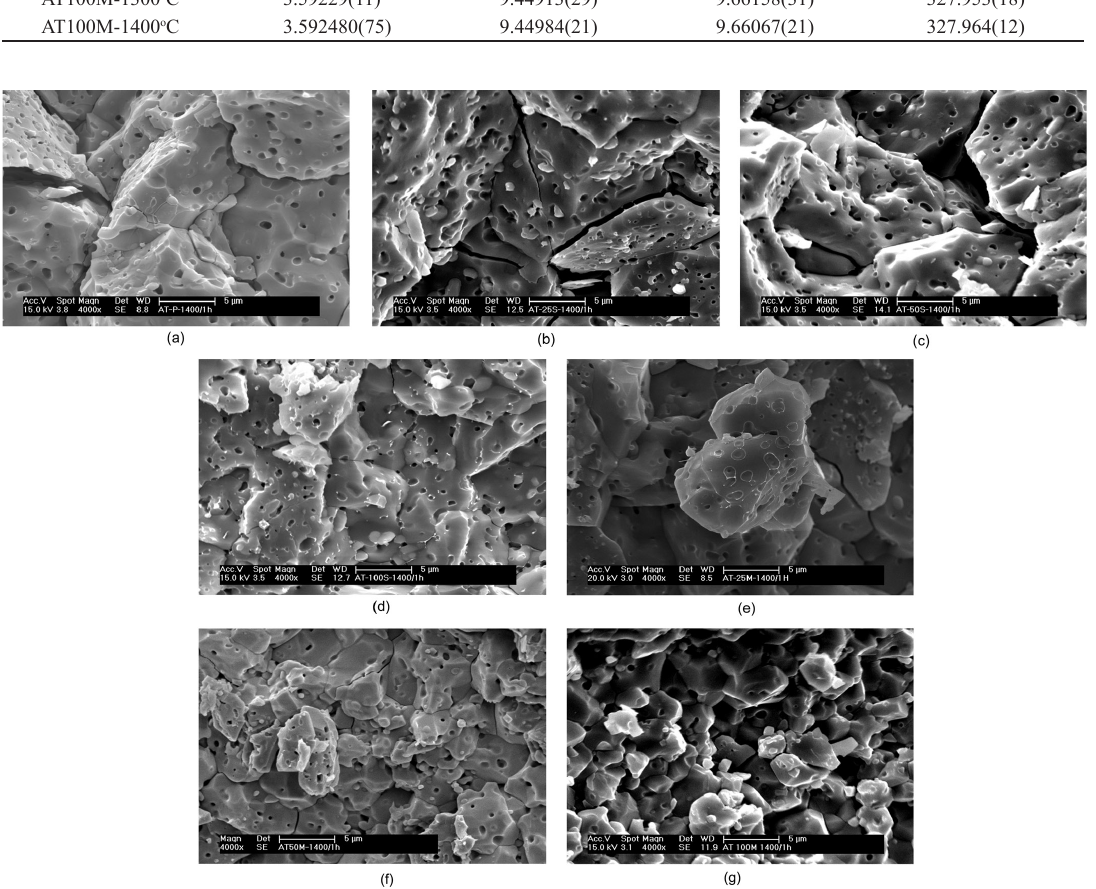
Figure 4. Scanning electron micrographs of the fracture surface of the samples treated at 1400 o C for 1 hour. (a) ATP, (b) AT25S (c), AT50S, (d) AT100S, (e) AT25M, (f) AT50M and (g)